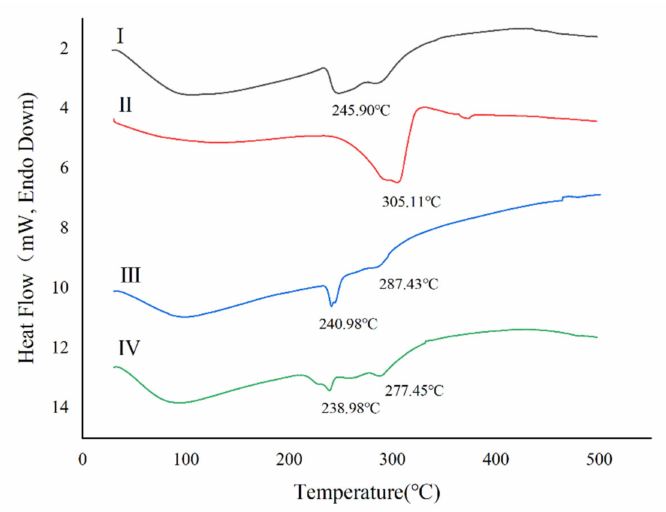
Figure 2. Differential scanning calorimetry (DSC) thermograms of ( I ) GM raw material. ( II ) Leu raw